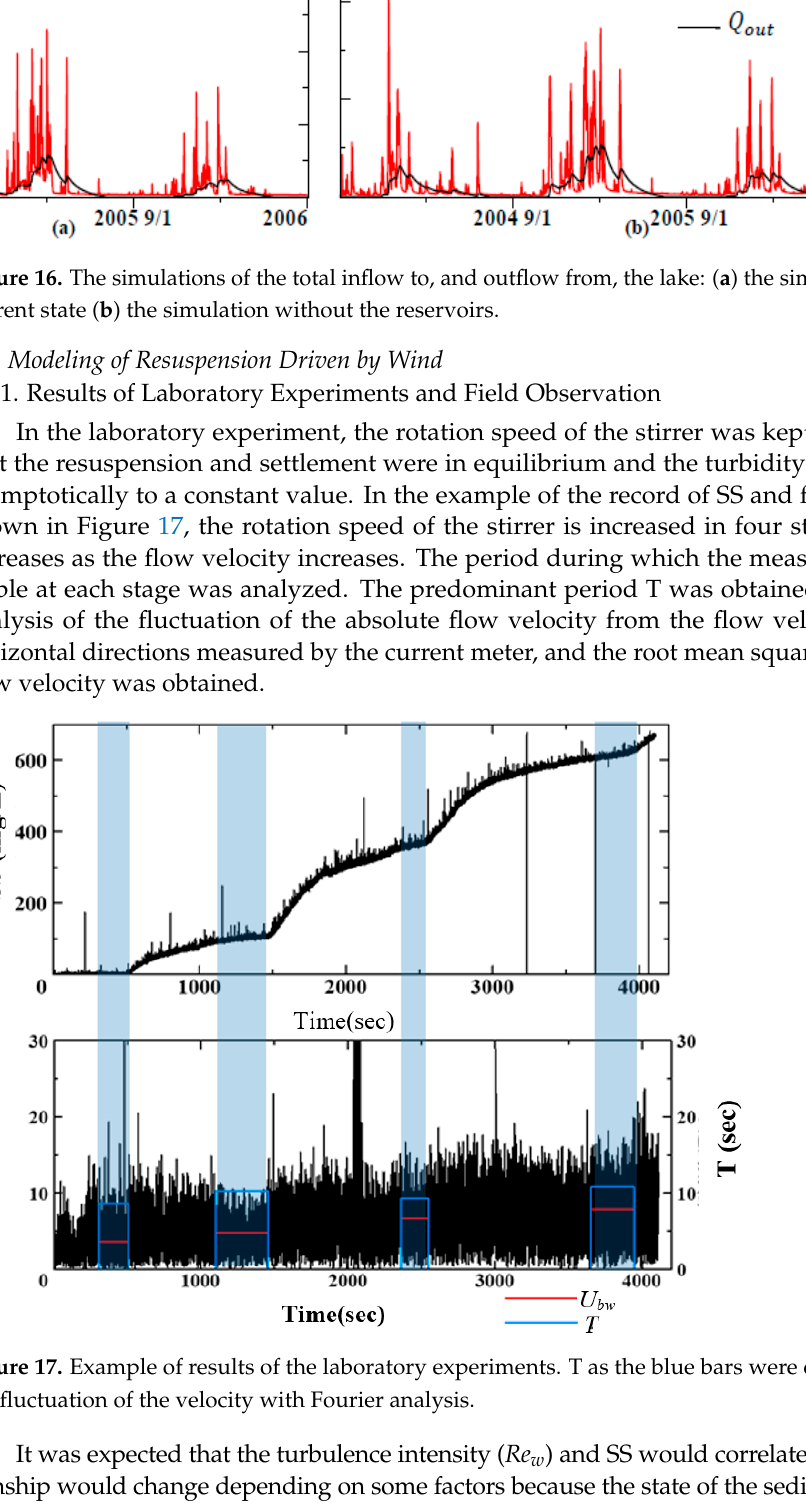
Figure 18. The relationship between turbulent intensity ( Re w ) and the concentration of suspended solids.